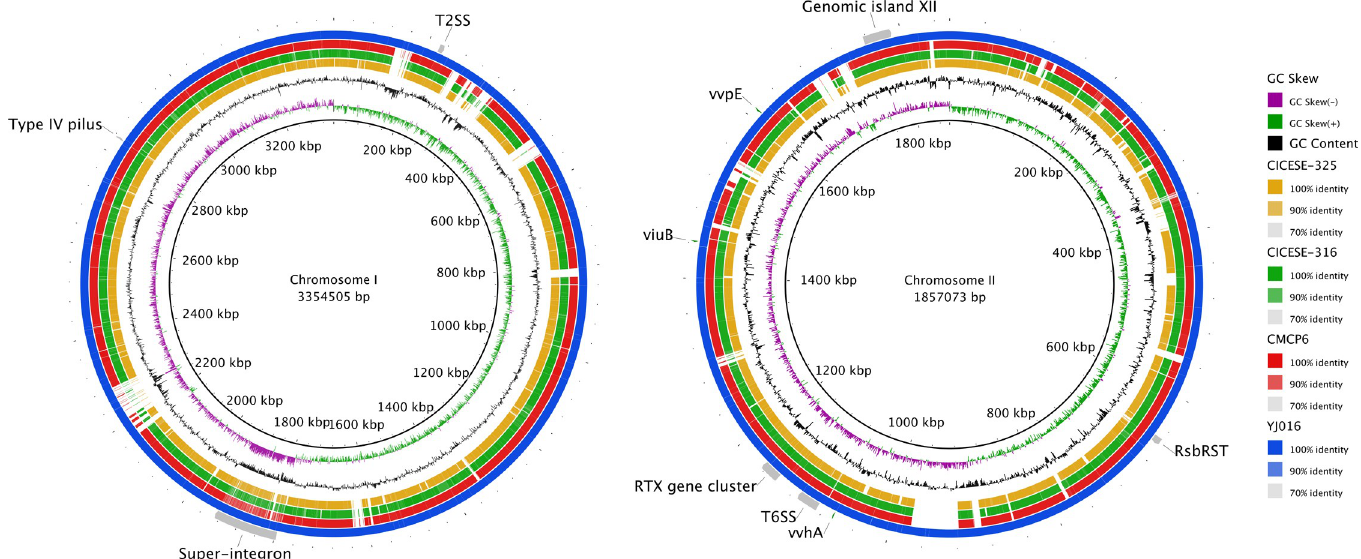
Fig 3. Circular maps alignment of V . vulnificus genomes CICESE-316, CICESE-325 and CMCP6, and YJ016 as reference genome, implemented with BRIG V0.95.